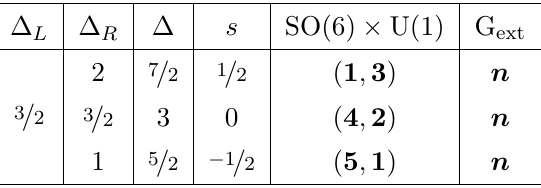
Table 10. Mass spectrum for the OSp(4 groups are of the form SO(5)